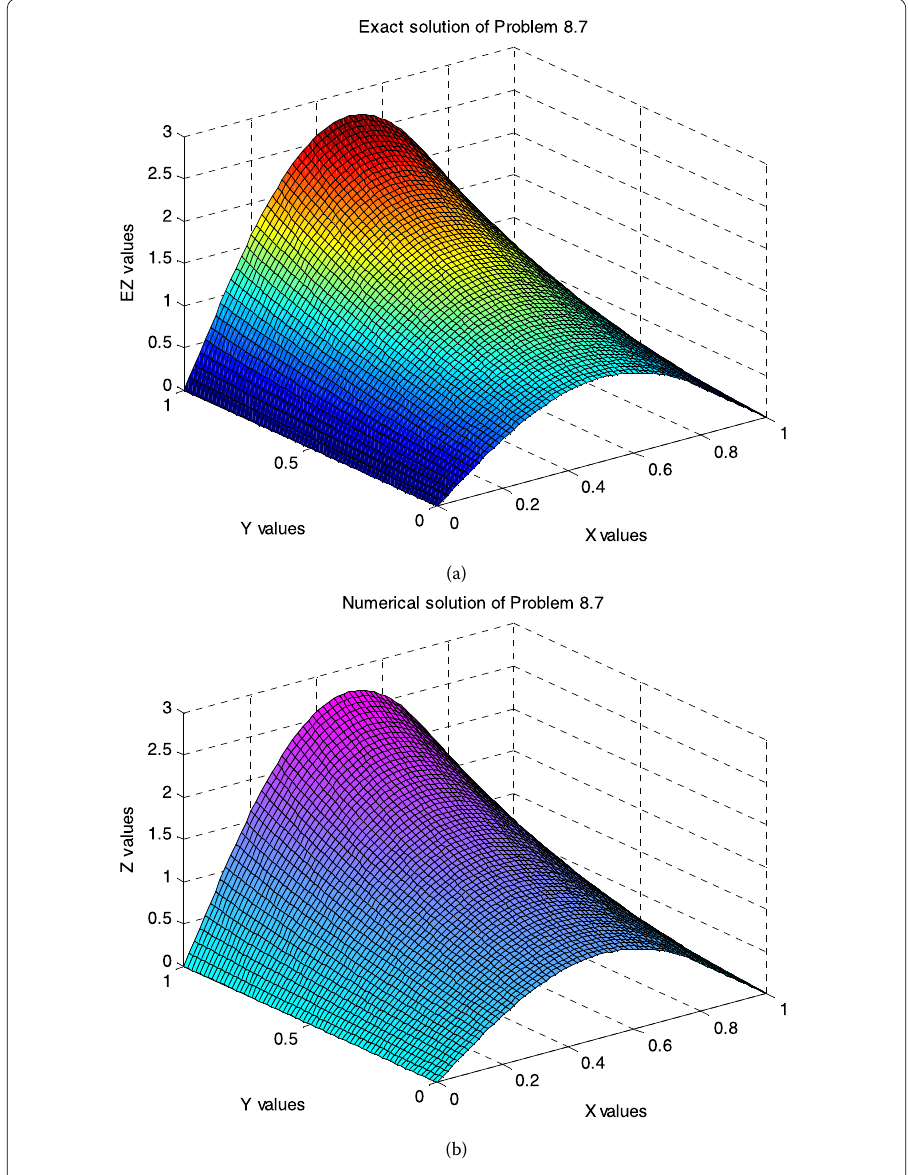
Figure 8 ( a ) Exact solution of Problem 8.7 for h = 1/64 and α = 1. ( b ) Numerical solution of Problem 8.7 for h = 1/64 and α = 1